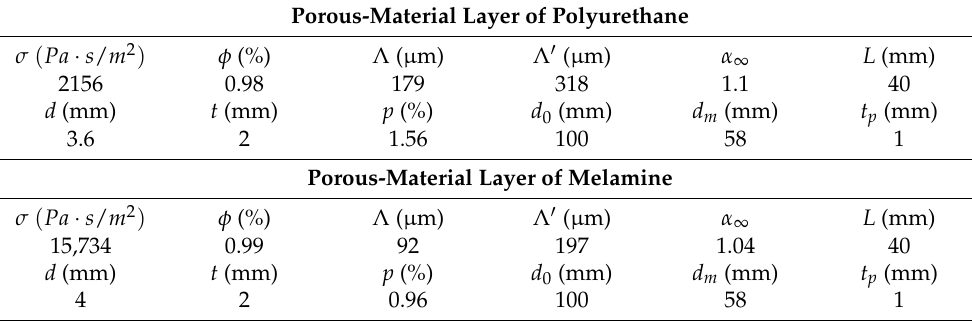
Figure 4. Sound absorption coefficients of PPCS under theory, simulation, and experiment. ( a ) Po- rous materials of melamine; ( b ) porous materials of polyurethane.